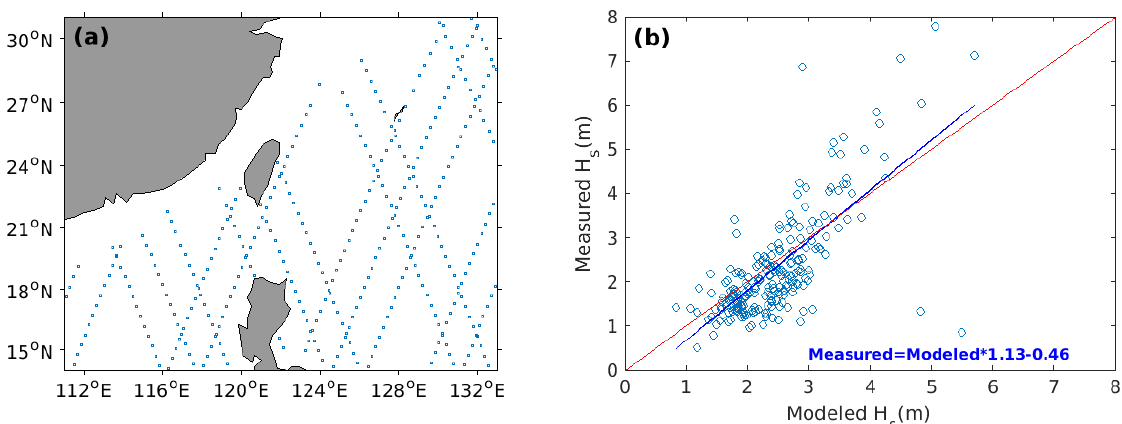
Figure 7. Comparison between Jason-2 observed H s and simulated H s : ( a ) ground track of the Jason-2 satellite from 0000 UTC on 26 July to 0000 UTC on 5 August and the study region; ( b ) significant wave height scatter plot, comparing model results and Jason-2 altimeter data.